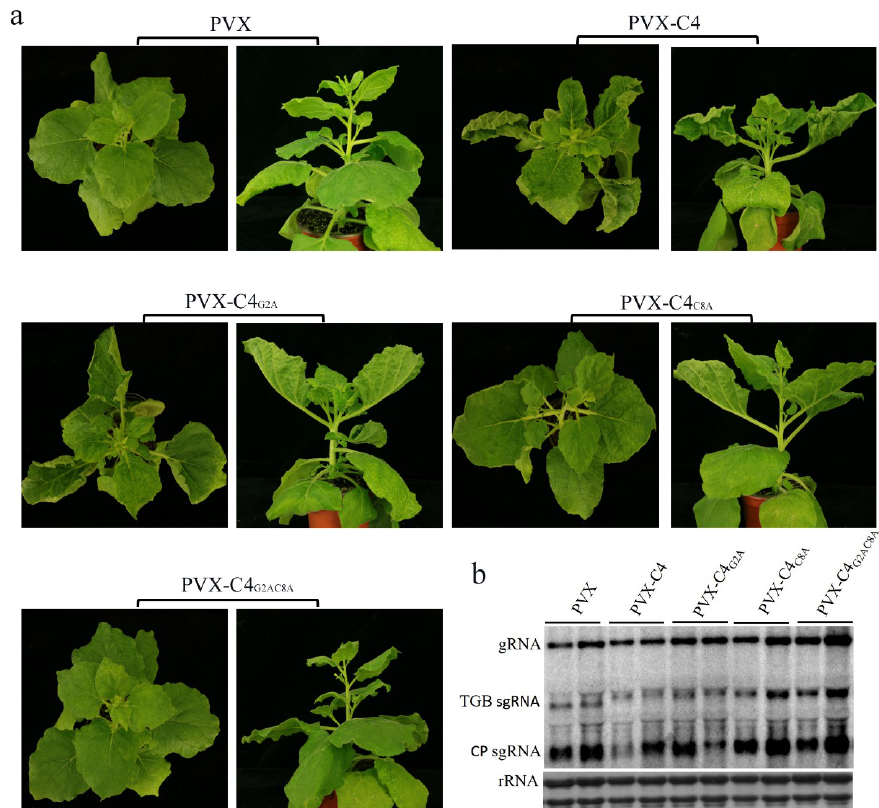
Figure 6. The N-terminal acylated residues of C4 are associated with its symptom determinant function. ( a ) Symptoms of N. benthamiana plants inoculated with PVX, PVX-C4, and PVX-C4 mutant variants mutated in its N-terminal potentially acylated sites. Symptoms were photographed at 21 dpi. The images shown are representative plants out of six plants inoculated with each construct in at least three independent experiments. PVX-C4 G2A showed PVX-C4-like phenotype with severe upward leaf curling, PVX-C4 C8A induced very mild upward leaf curling, and PVX-C4 G2AC8A -infected plants showed PVX-like symptoms. ( b ) Northern blotting analyses of viral RNA accumulation showed that there were no obvious differences among PVX-C4 mutant variants-inoculated plants compared to PVX- and PVX-C4-inoculated plants. The blot shown is a representative one out of three independent experiments. The probe used was specific for PVX RNA.